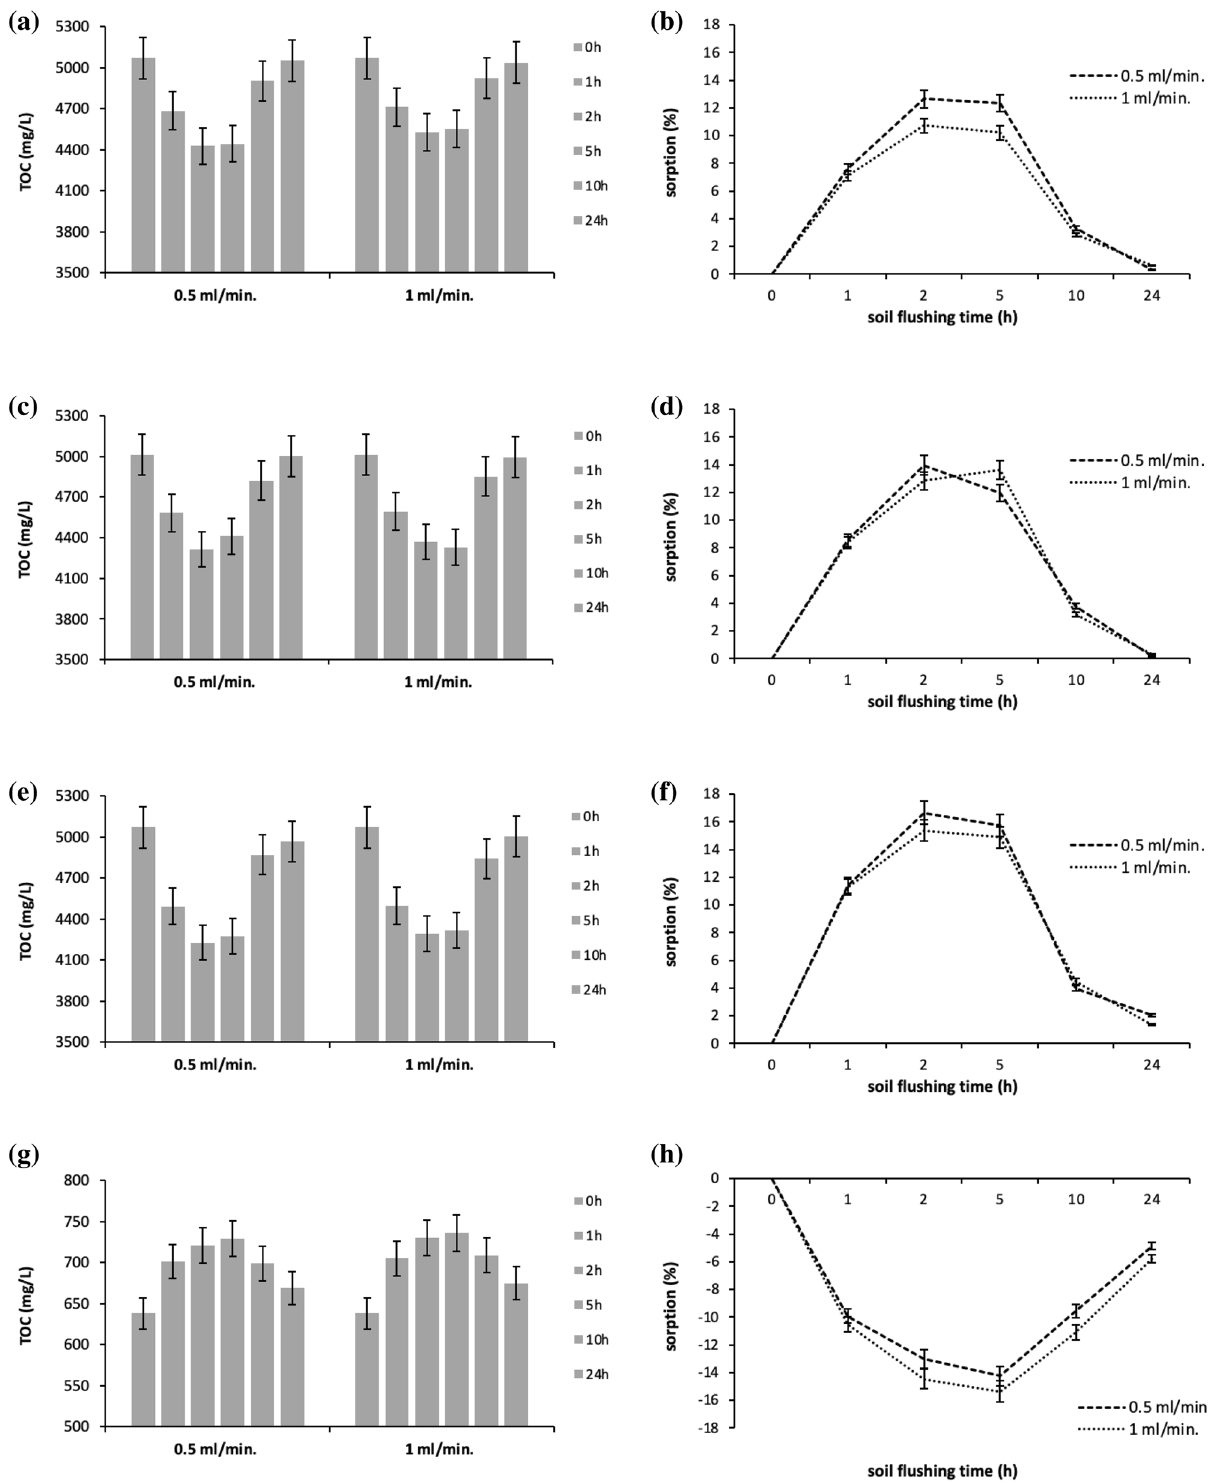
Figure 4. Changes in the concentration of WAs (as TOC) in leachate collected, and the sorption of WAs at specific flushing time (0–24 h) at two flow rates: ( a , b ) DOM, ( c , d ) HLS, ( e , f ) SHS, ( g , h ) Na 2 EDTA. Data are expressed as mean values (n = 2) ± standard deviation error